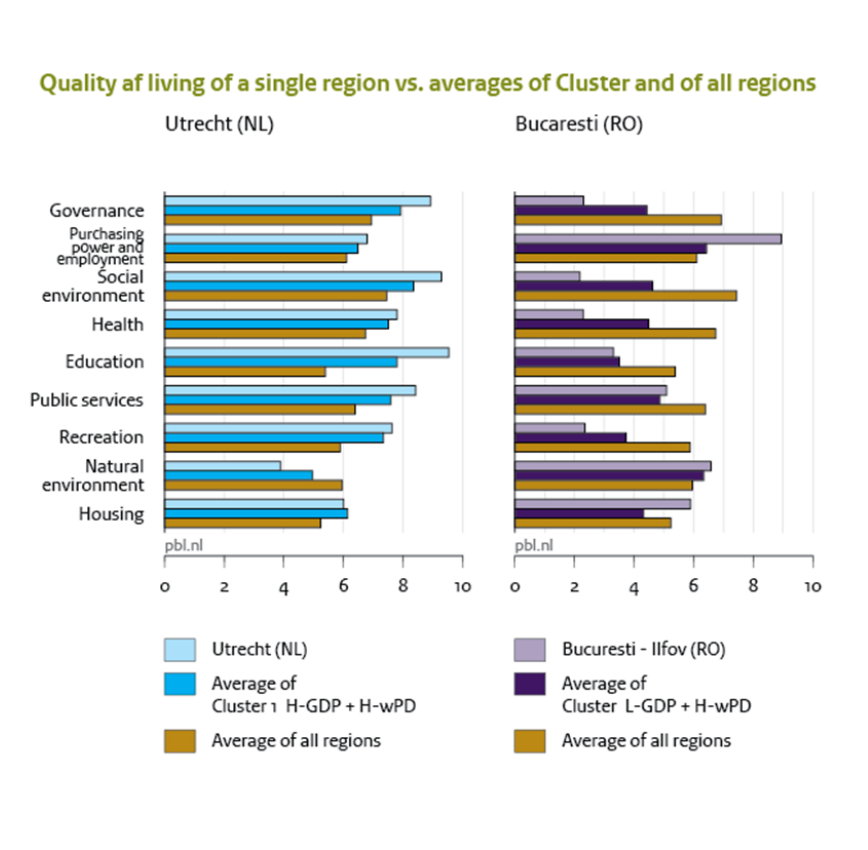
Figure 9: Examples of benchmarking European regions with their peers